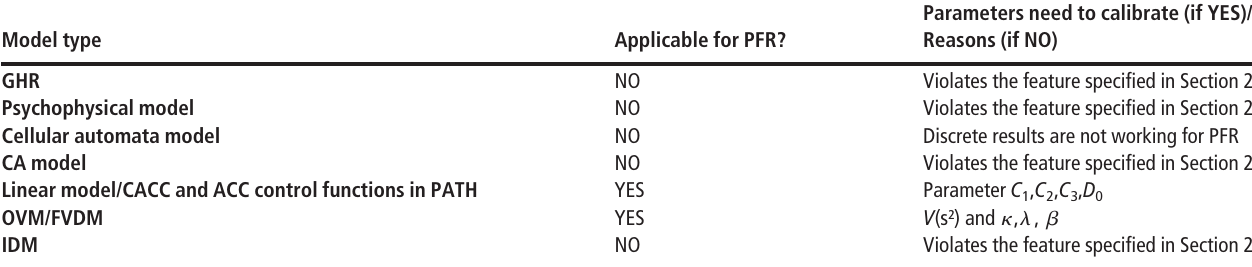
Table 1 Car-following model feasibility analysis results for PFRs Model